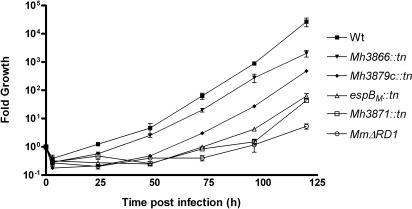
Growth of M. marinum Secretion Mutants in BMDMsBMDMs were infected with M. marinum strains as described in Materials and Methods at a multiplicity of infection of 1, and growth of bacteria was monitored over time as in Figure 1. Data are summarized from three independent experiments. Strains differed significantly by one-way ANOVA after 24 h, 48 h, 72 h, 96 h, and 120 h (p < 0.001 for each).